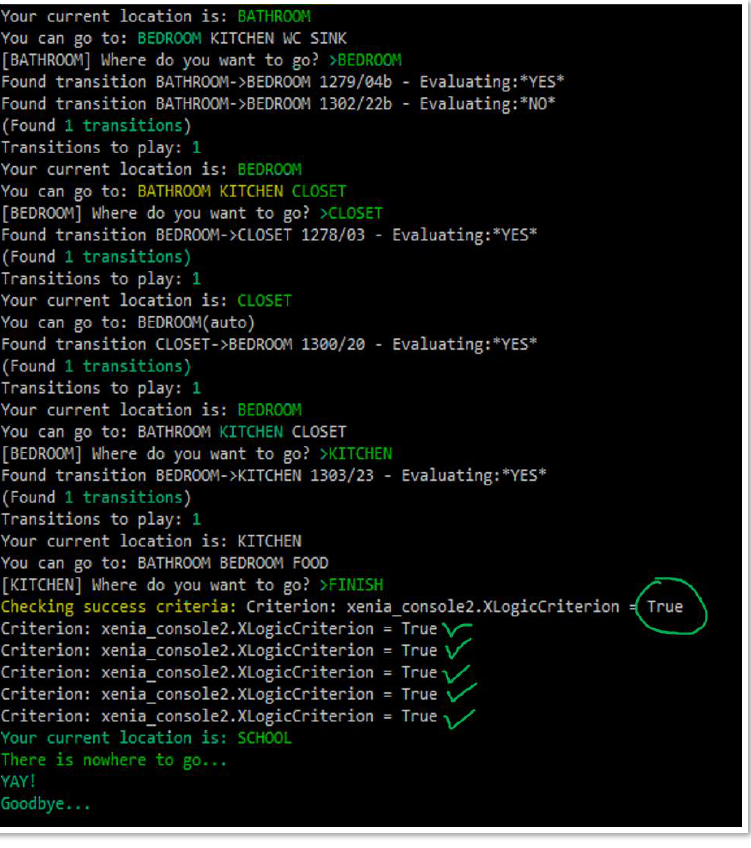
Figure 31. Game logic: all criteria are met.